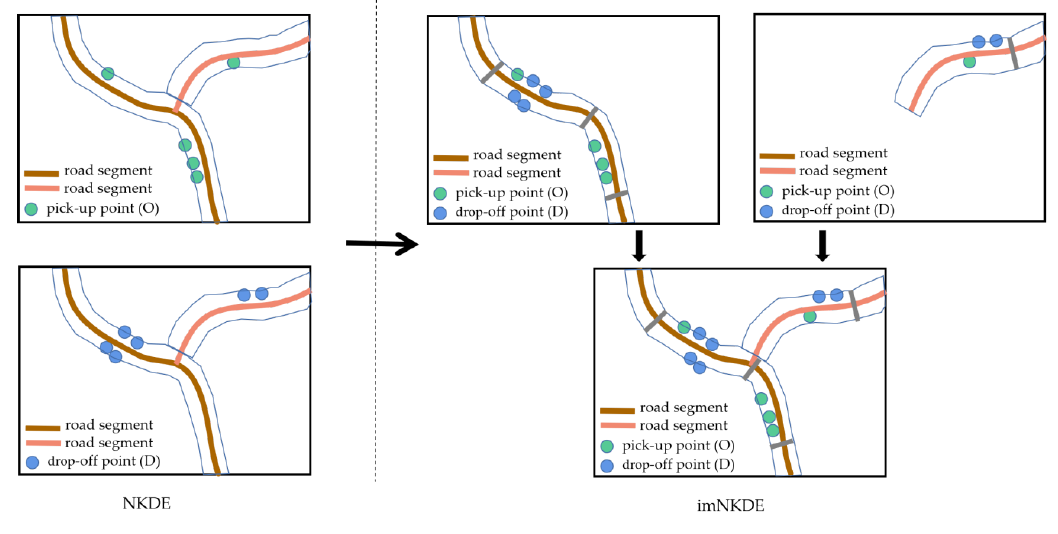
Figure 7. S chematic for imNKDE. Figure 7. Schematic for